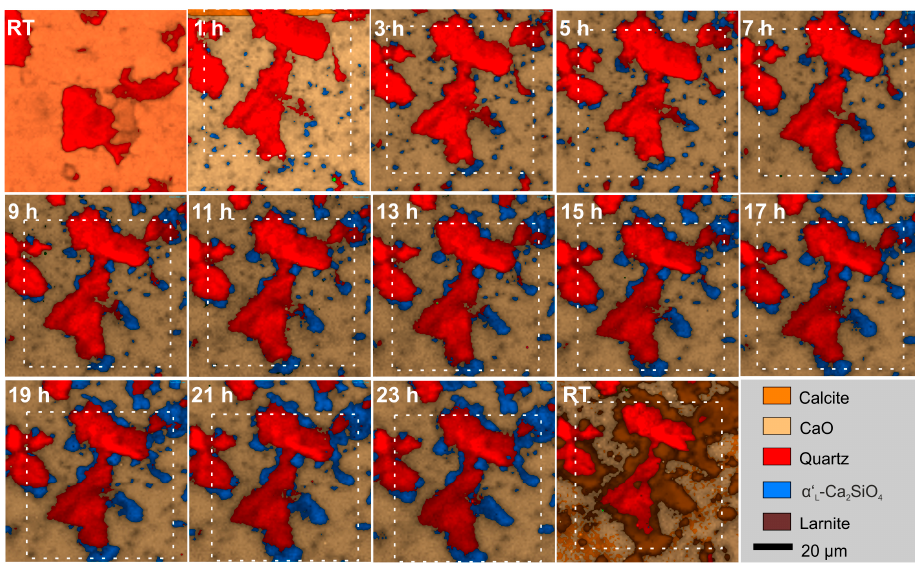
Figure 13. Hyperspectral Raman images of a green body composed of a mixture of quartz and CaO (mass ratio 1:1). The sample was fired with a heating rate of 10 °C to 848 ± 5 °C and 12 hyperspectral Raman images (100 × 100 µ m, 1 µ m step size, SWIFT 1.6 µ m/s) were subsequently recorded